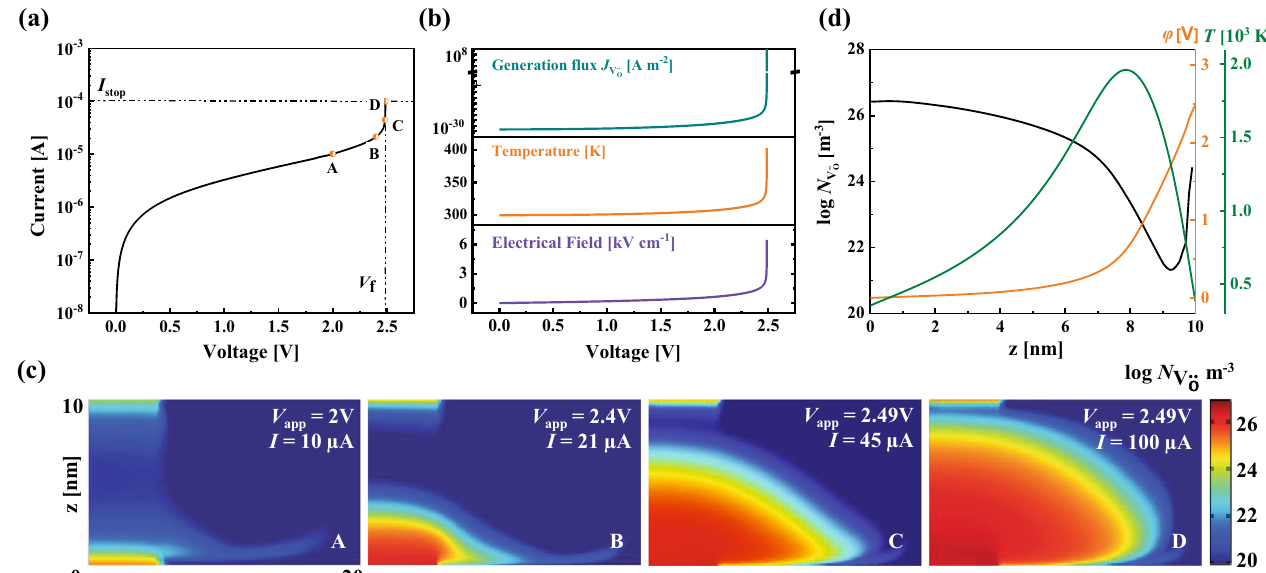
Fig. 1 Modeling electroforming process in HfO 2 metal oxide. a Current evolution characteristic by applied voltage sweep with rate d V /d t = 1 V s − 1 and stop at I stop = 100 µA. b The evolution of generation fl ux, temperature T, and electrical fi eld E at the anodic interface ( z = 10 nm). c Calculated 2D N V :: maps with increasing voltage, corresponding to state A – D in ( a ). d 1D pro fi les of N V :: o the center of CF ( x = 0, z = 0 – 10